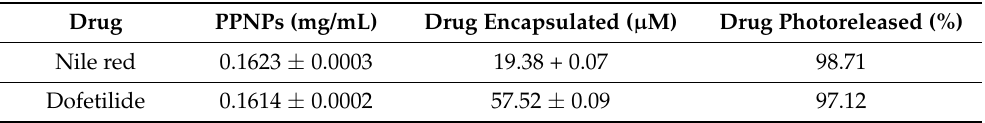
Table 5. Concentrations and percentages of drugs encapsulated and photoreleased in DMSO by UV irradiation of